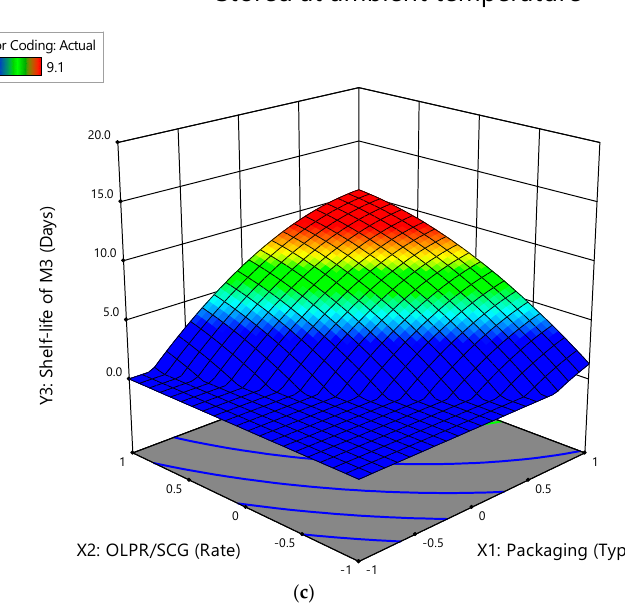
Figure 3. Three-dimensional surface plots for the interactive effect of packaging type and OLPR, SCG, and OLPR/SCG rates on shelf-life during storage at ambient temperature: ( a ) M 1 (mushrooms of WS and OLPR mixtures); ( b ) M 2 (mushrooms of WS and SCG mixtures); and ( c ) M 3 (mushrooms of WS and OLPR/SCG